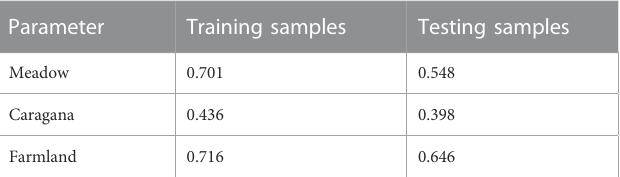
TABLE 5 Accuracy assessment of the biomass neural network model for three parameters. Parameter Training